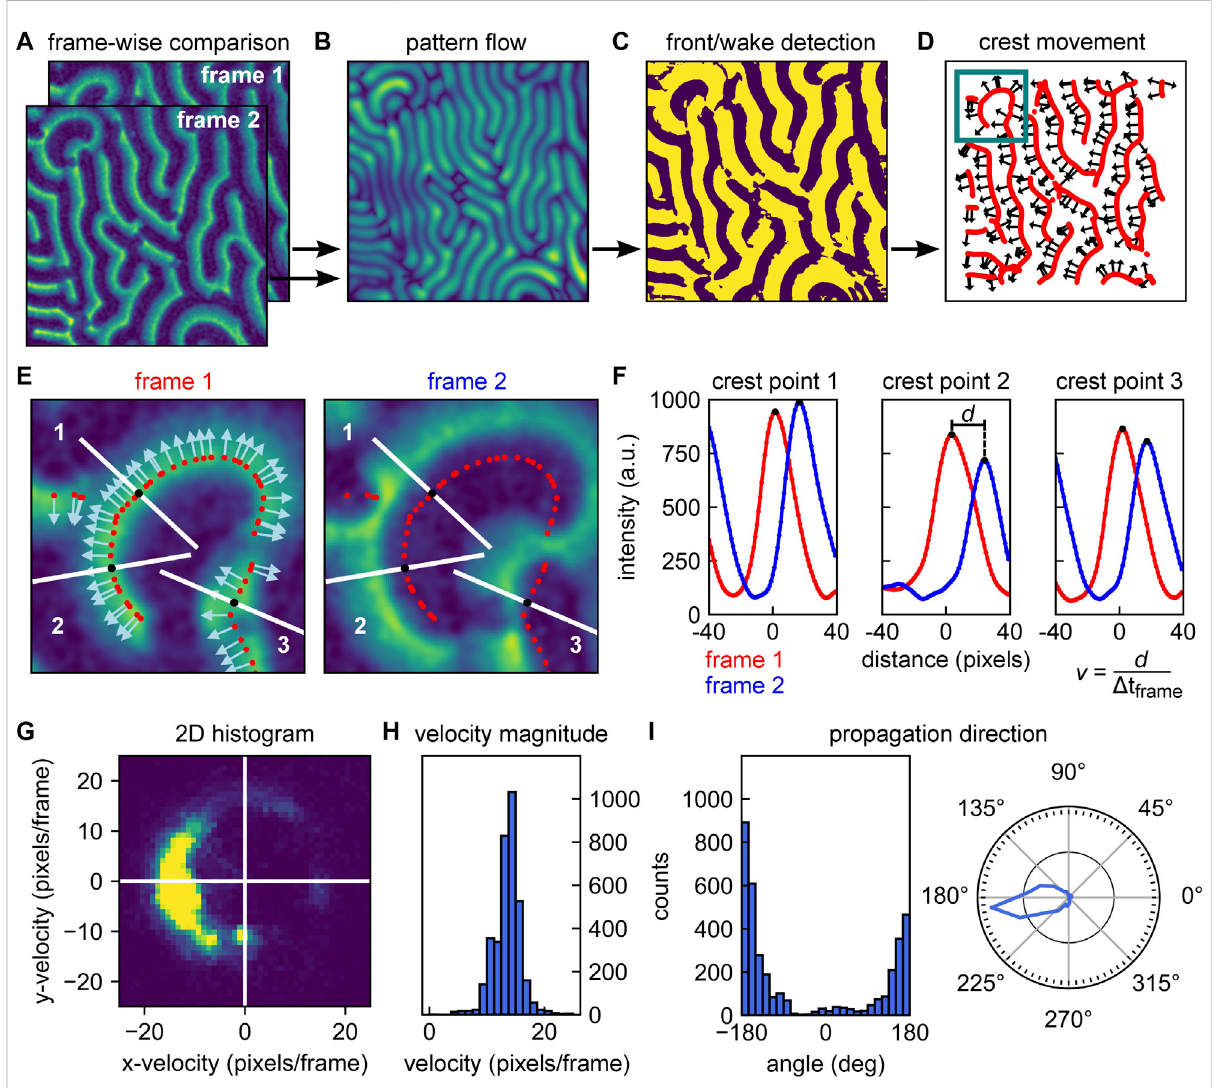
FIGURE 3 Overview of analysis pipeline for determining local wave propagation velocities. (A) Local analysis relies on sequential pairwise comparison of frames within an image stack. Example frames are here referred to as frame 1 and frame 2. (B) The Horn-Schunck algorithms is used to compute optical fl ow of the image pair (from frame 1 to frame 2) These return one vector per pixel, indicating the shift. Brightness indicates the vector magnitude. (C) Phase image of frame 1. The phase is determined by whether the wave intensity goes up ( “ front ” of the wave, bright color) or down ( “ wake ” of the wave, dark color) following the direction of the vector obtained from the optical fl ow analysis. (D) Wave crests can be identi fi ed bythetransitionsfromfronttowakeas denotedinpanelC.Red linesshow theidenti fi edwavecrestlocations.Selectedarrowsindicatethedirection ofmovementof thecrests as determined from theoptical fl ow. (E) Left: Zoom-in offrame 1 atthelocation highlightedinpanel D. Wave crest points areindicatedbyreddots;directionofmovementasidenti fi edbyoptical fl owanalysis areindicatedbyarrows.Right:Zoom-in offrame2 atthesame location. Crest points of frame 1 are indicated by red dots. In both images, 3 crest point positions are highlighted by white line traces parallel to the direction of propagation at these points (i.e., normal to the wave fronts). (F) Intensities versus distance along the white lines in panel E. Starting from thecrestsidenti fi edforframe1(reddots),intensitiesaresampledatdiscretesub-pixelpositionsperpendiculartothewavefront.Smoothedintensity tracesareshown inredforframe1andinblueforframe2.Thetranslocation d ofeachcrestpositionisthen determinedfromthepeakshift,allowing to calculatea velocity vector with magnitude v . Wave crest velocitiescan be calculated for each crestand each sequential pair of frames in an image stack. (G) Velocitydistributionofapatterncanbevisualizedasa2Dhistogram. (H) Velocityhistogramthatprovidestheaveragevelocitymagnitude v as well as the distribution of velocities within a given pattern. (I) Histogram of angles of the wave propagation vector (left) and an angular diagram denoting the occurrence of various pattern velocities (right). From the list of velocity vectors, we have immediate access to the propagation directions present within a pattern, the occurrence of which can be visualized in a histogram (left). The information can be represented as a polar histogram